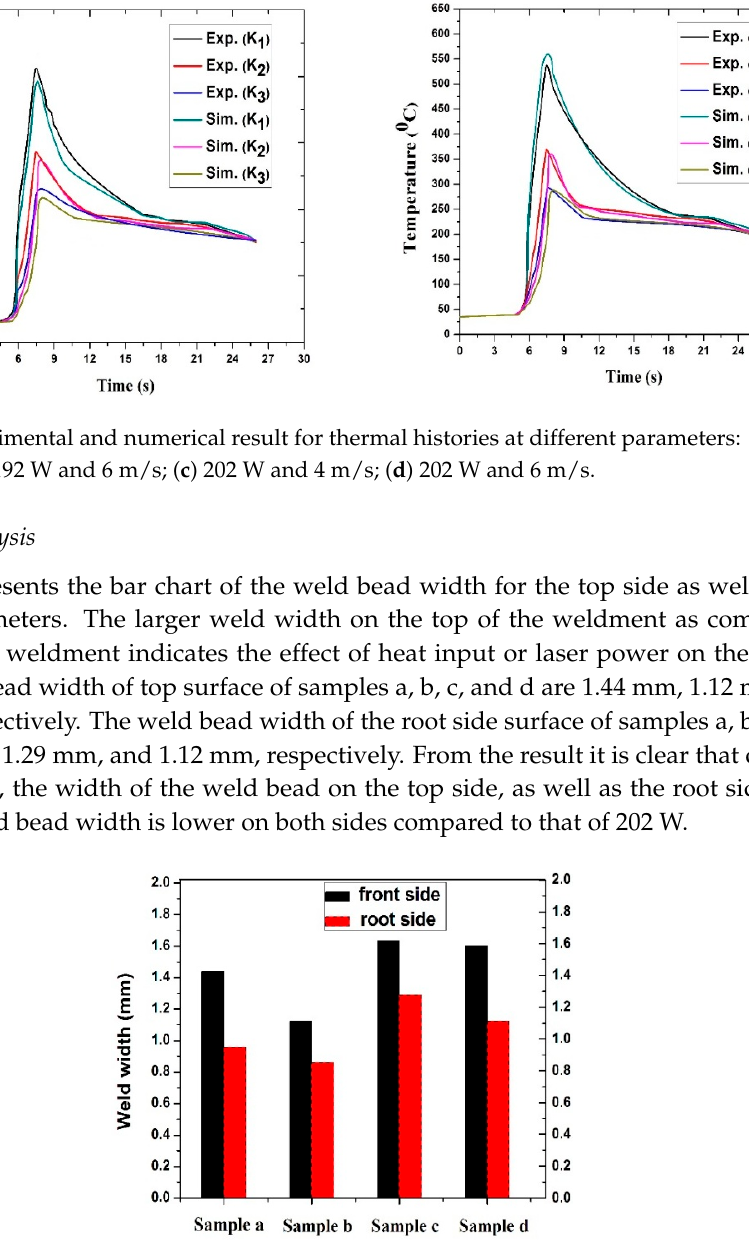
Figure 8. Bar chart of weld width of the different specimens.